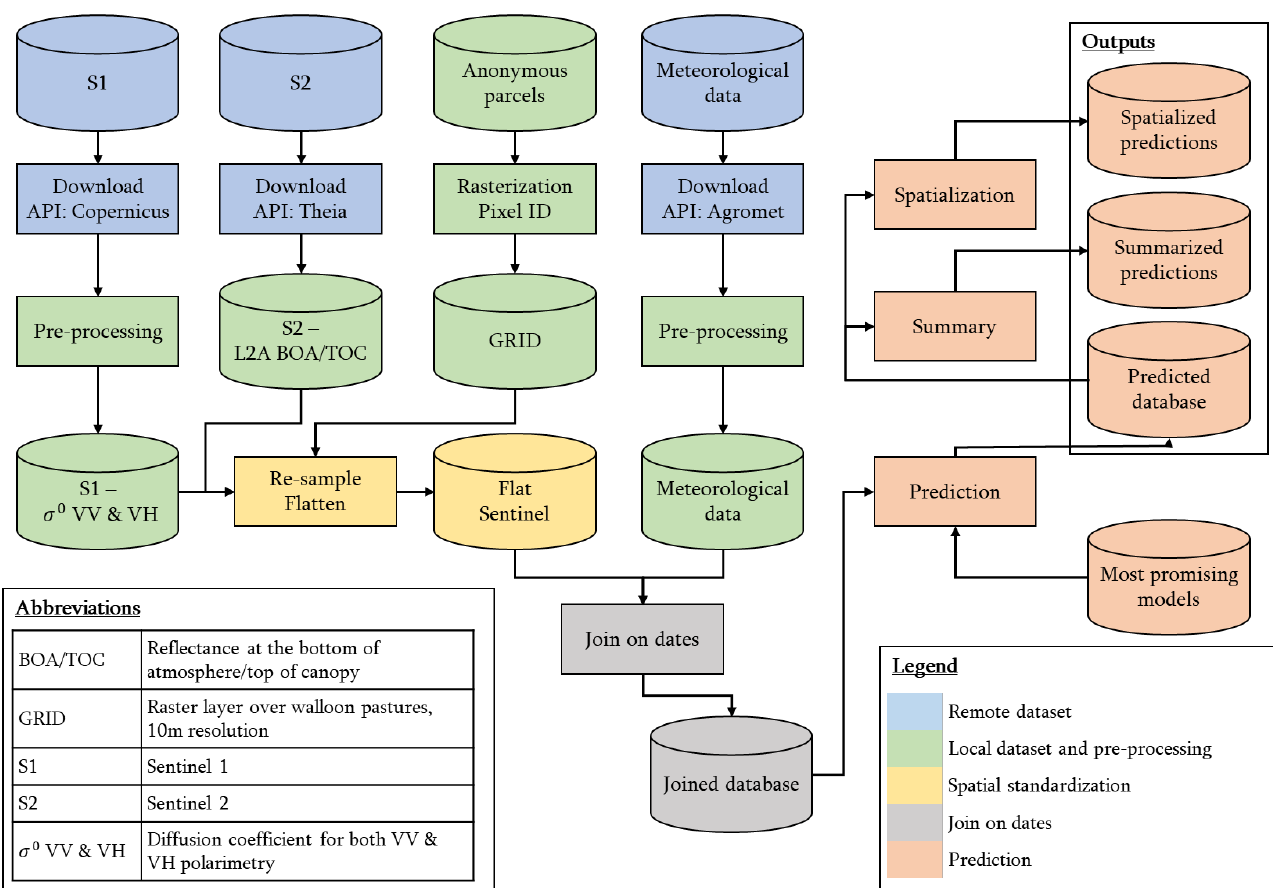
Figure 1. Design of the prediction platform. Table 1. List of software and package used.